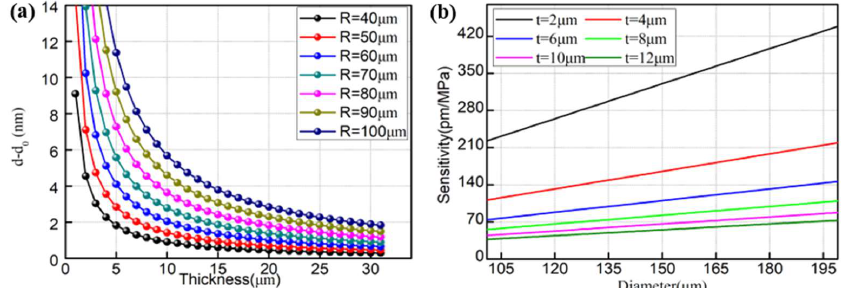
Figure 3. Theoretical calculations on ( a ) cavity length change versus the bubble thickness and ( b ) pressure sensitivity as a function of bubble thickness under different cavity lengths.